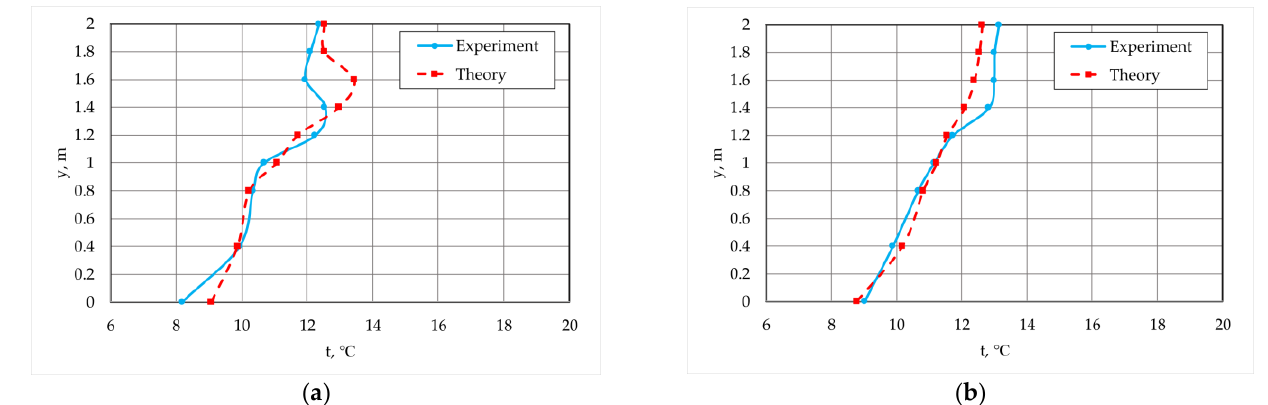
Figure 10. Distribution of experimental and theoretical values of air temperature along the Y coor- dinate ( τ = 60 min): ( a ) at X = 0.8 m and ( b ) at X = 2.4 m.